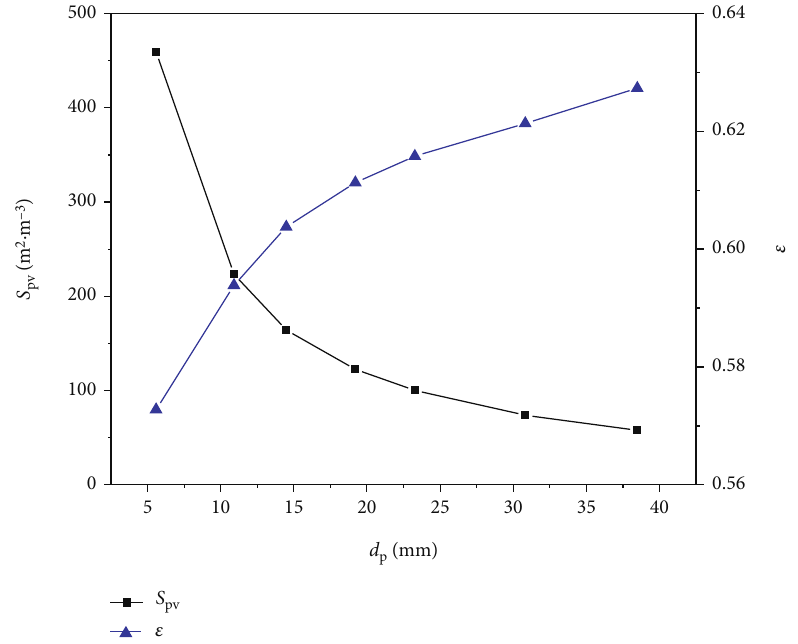
Figure 18: Variation of the speci fi c surface area S